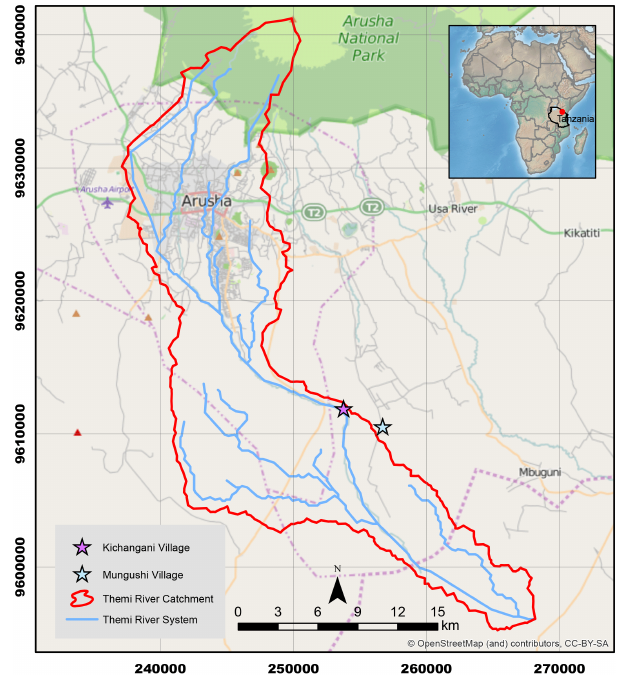
Figure 1. Themi river catchment at Arusha, Tanzania, and the two farming villages Mungushi and Kichangani were the wetness classi- fication scheme was tested. (Background: OpenStreetMap and con- tributors, CC-BY-SA, insert map: Natural Earth.)